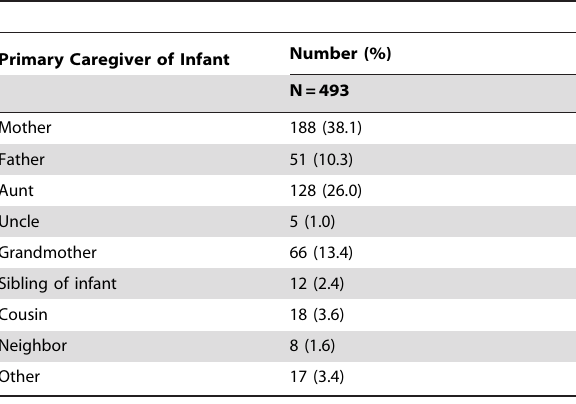
Table 2. Primary Caregiver of Infants Enrolled in RUIF Program, April–June 2010.